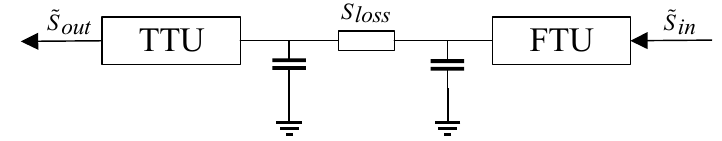
Figure 7. Power flow relationship between FTU and TTU.